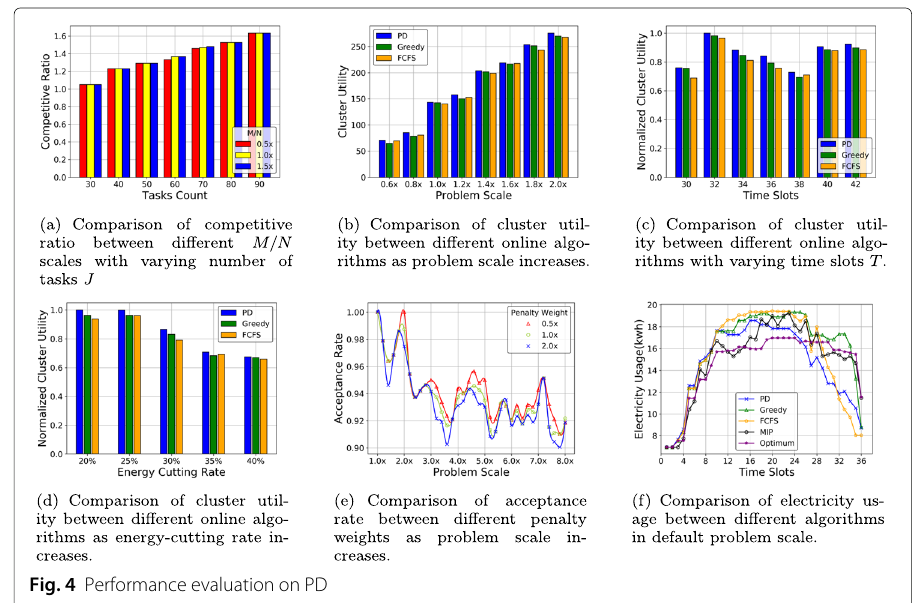
Fig. 4 Performance evaluation on